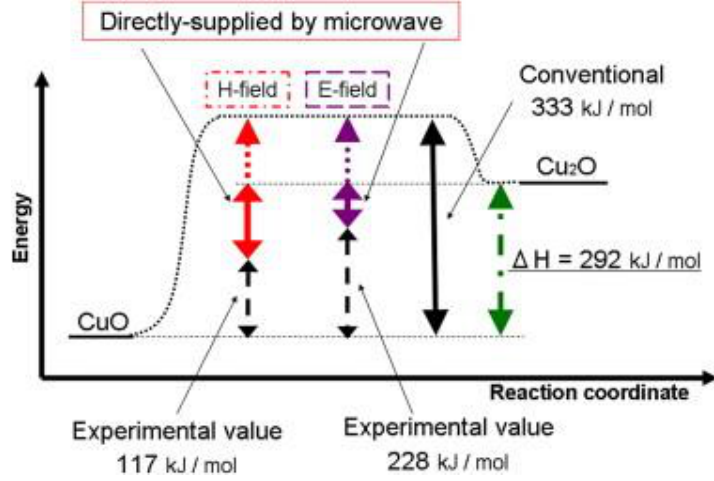
Figure 6. Reaction coordinates of CuO reduction under conventional heating, E -field microwave heating, and H -field microwave heating.